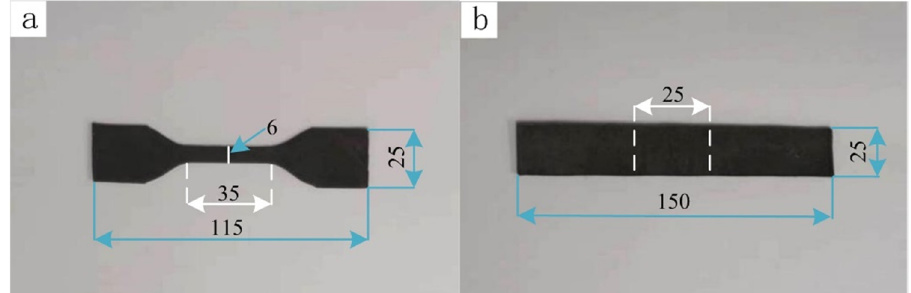
Figure 2: ( a ) Dumbbell - shaped rubber specimen and ( b ) cord – rubber composite